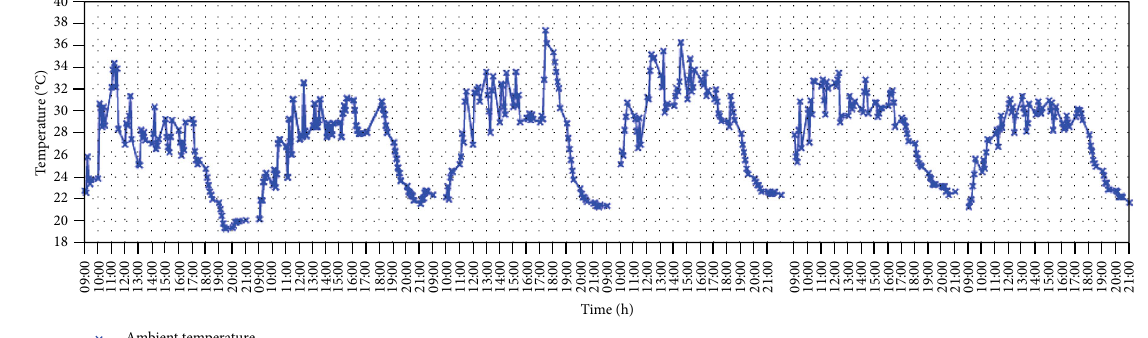
Figure 5: Variation of ambient temperature with time during the days of experiment.